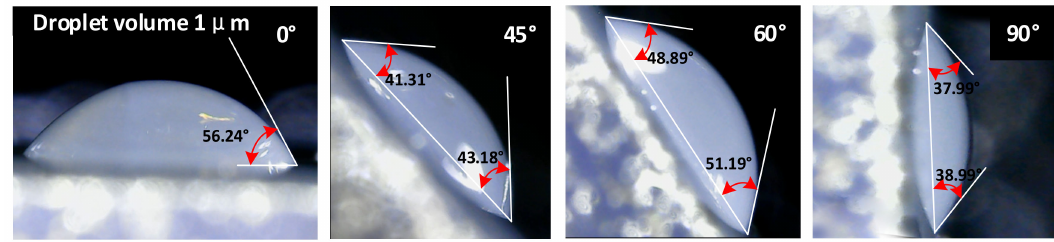
Figure 5. States of droplets on substrates after spreading are the same at di ff erent contact angles.